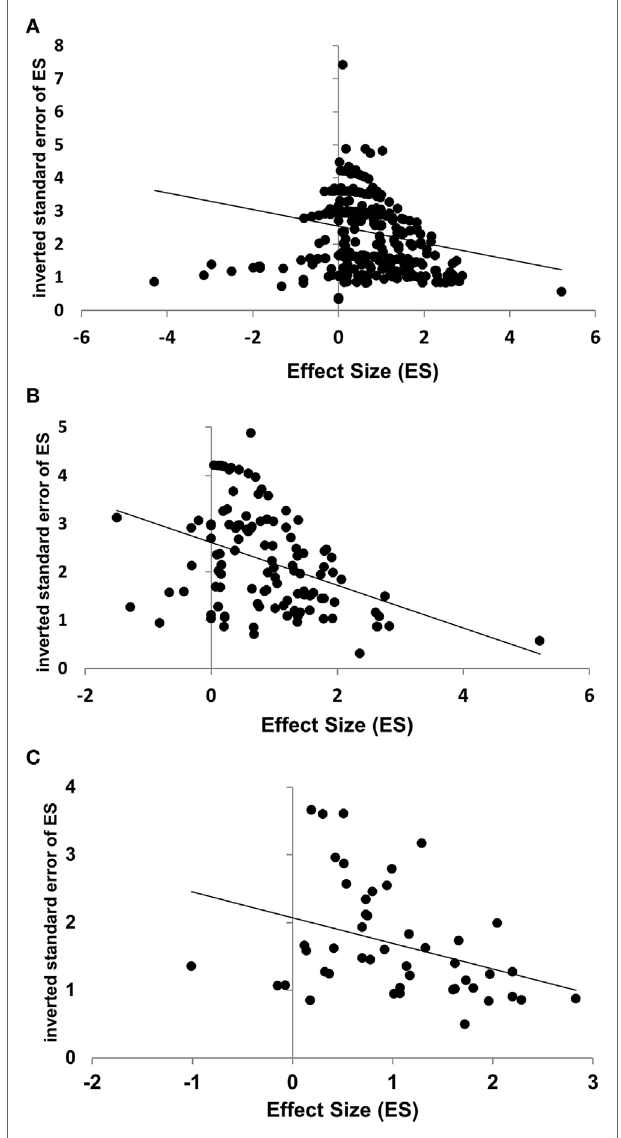
FiguRe 2 | Negative correlations between effect size (ES) and its reliability, estimated by the inverted standard error (1/SE), for all individual datasets [ (a) : Spearman’s ρ = − 0.22, p < 0.001], datasets included in the meta-analysis [ (B) : ρ = − 0.47, p < 0.001], and for mean ESs per record [ (c) : ρ = − 0.41, p = 0.004]. The regression lines are presented for illustration only, not for quantitative